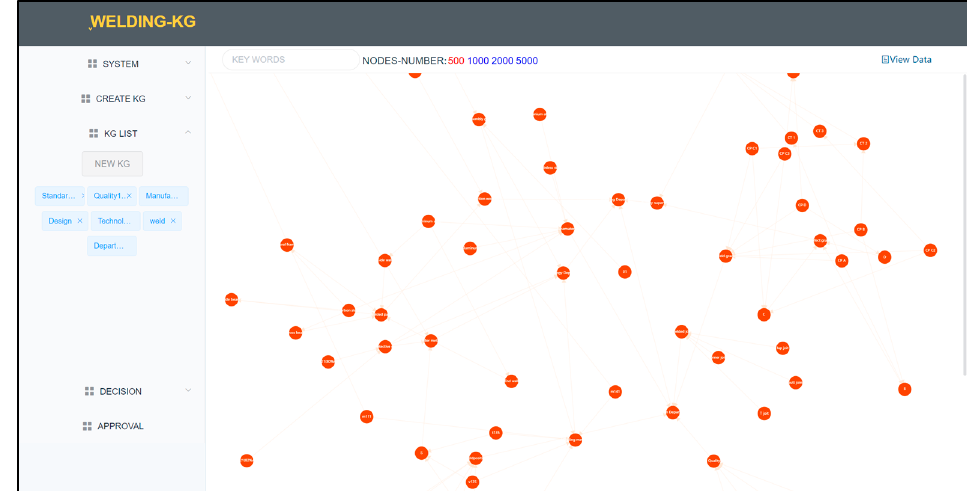
Figure 7. Knowledge graph view and search.